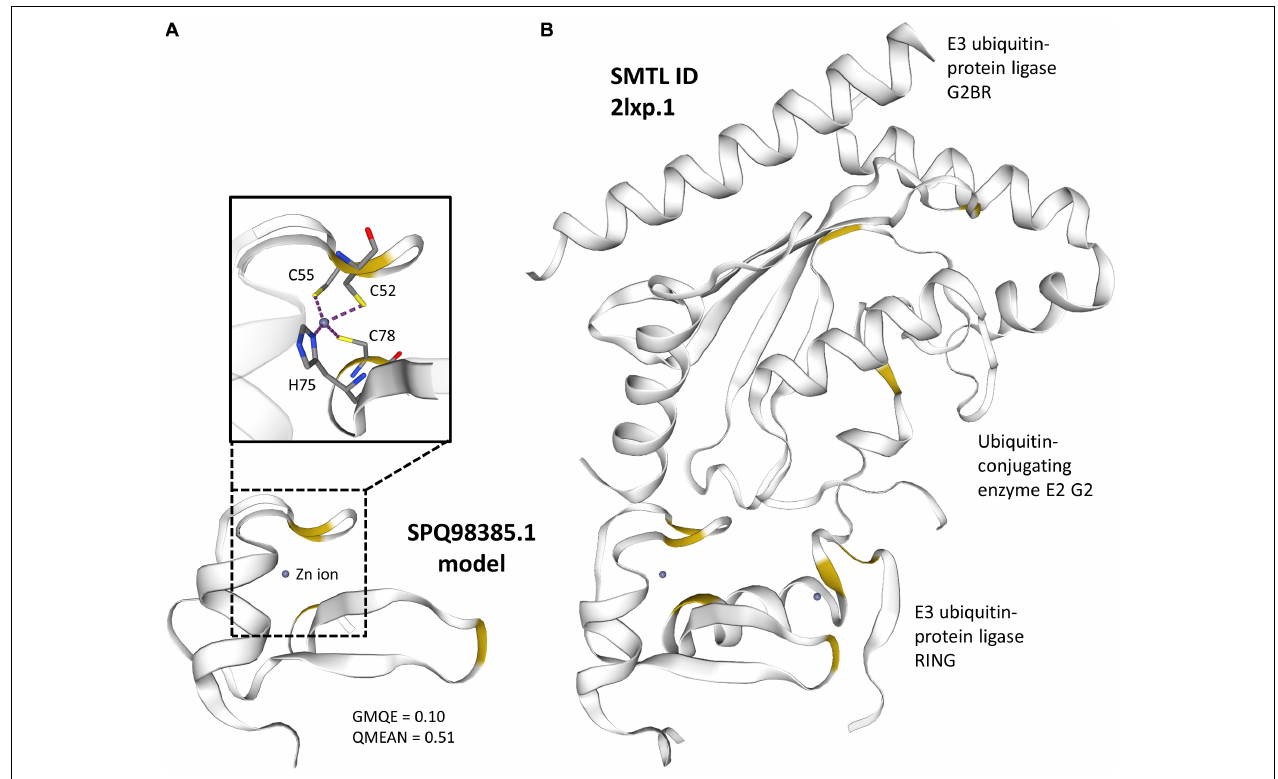
FIGURE 1 | Predicted 3D structure of E3 Ubiquitin-Protein Ligase RING subunit. (A) The region corresponding to the RING region of the E3 ubiquitin protein ligase was predicted using Swiss-model. A Global Model Quality Estimation (GMQE) score closer to 1 represents more accuracy in the models, and a QMEAN value above –4 is indicative of good quality of the structure (https://swissmodel.expasy.org/docs/help). The zinc-binding region is indicated by a dashed square on the model with the metal complexes between Zn and amino acids shown above. (B) The selected Swiss-Model Template (SMTL) to create the model of the P. brassicae protein is a complex of three units including two E3 ligases and an ubiquitin-conjugating E2 enzymes. Cysteine regions in both models are highlighted in